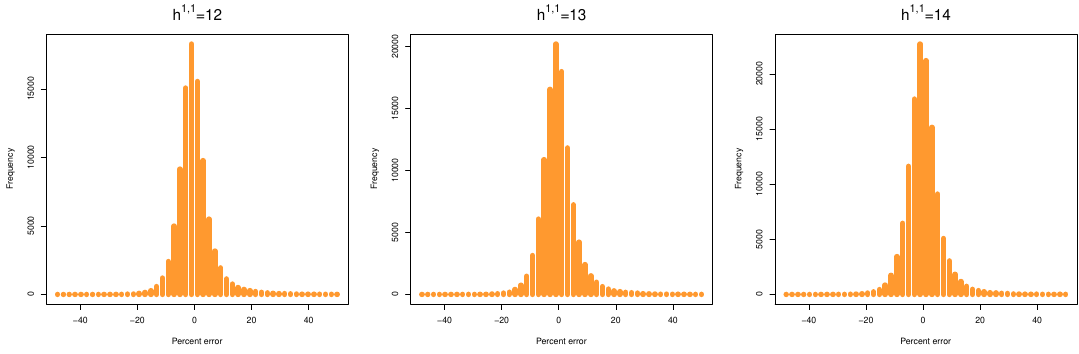
Figure 7 . Histograms of the percent error of our chosen model’s predictions in the extrapolation region. Compare to extrapolations in the EQL network in (cid:12)gure